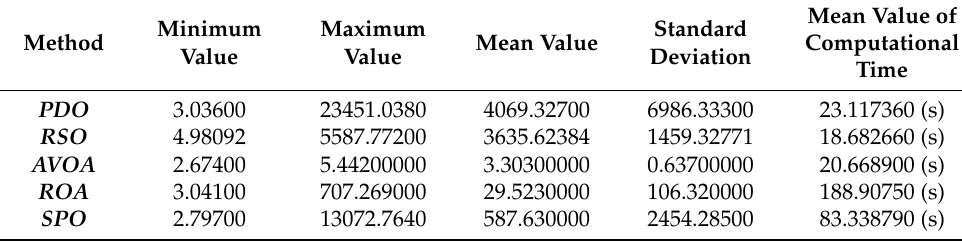
Table 17. Statistical analysis for proposed algorithms with case 4.